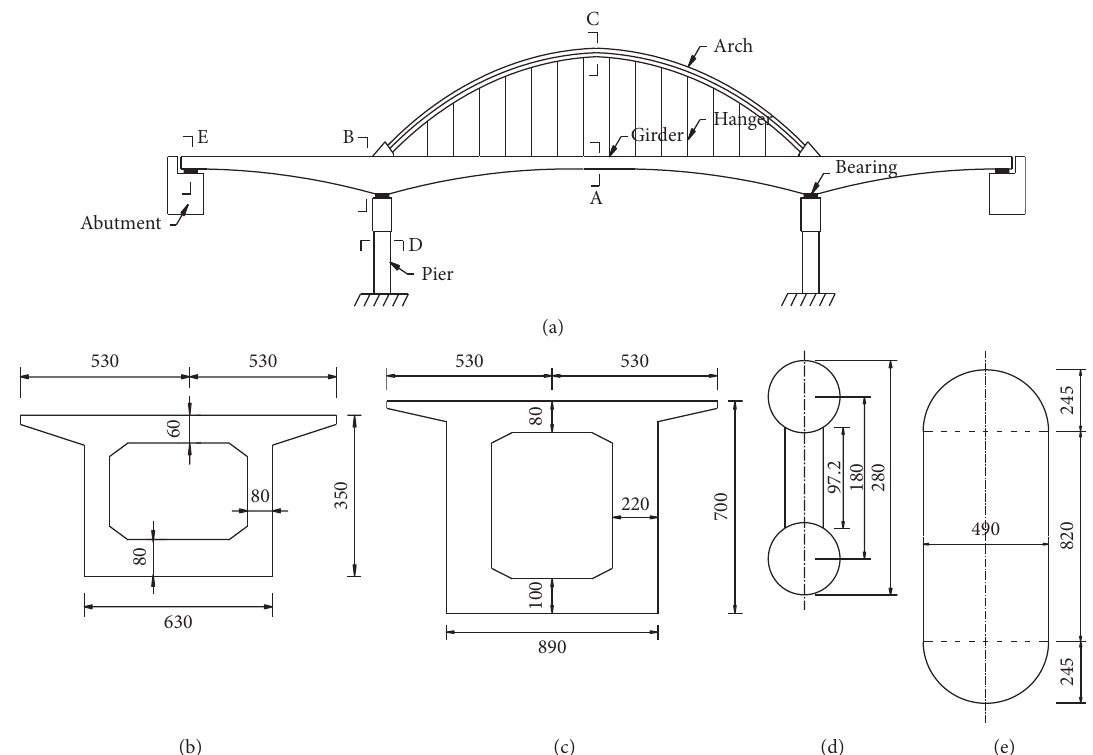
Figure 1: Long-span railway continuous beam-arch bridge (unit: cm): (a) elevation view of the bridge; (b) section A-A; (c) section B-B; (d) section C-C; (e) section